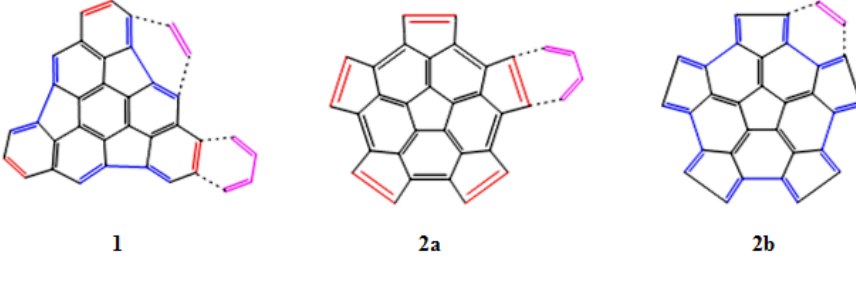
Figure 3. DA reaction of the fragments 1 and 2 with a diene (1,3-butadiene) and a dienophile